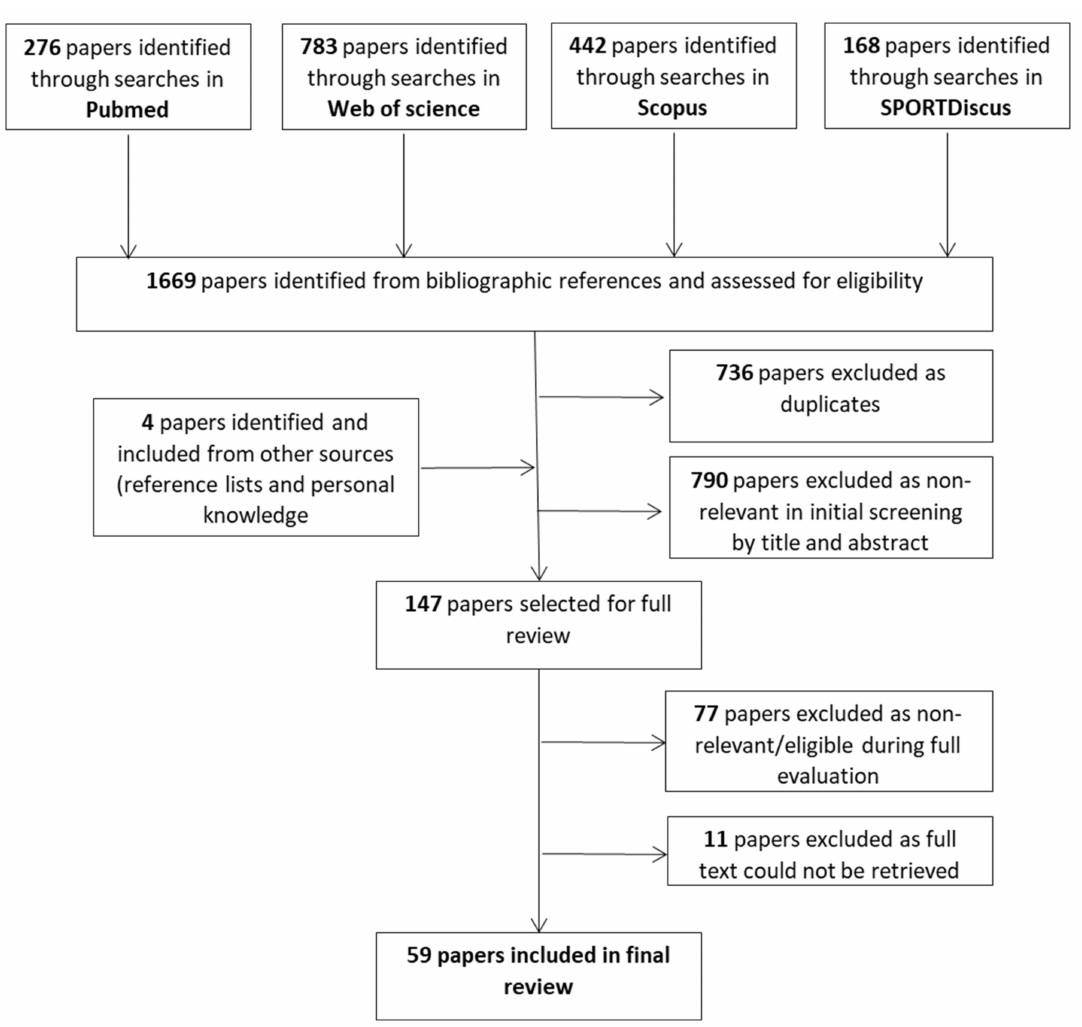
Figure 1. The literature search and review